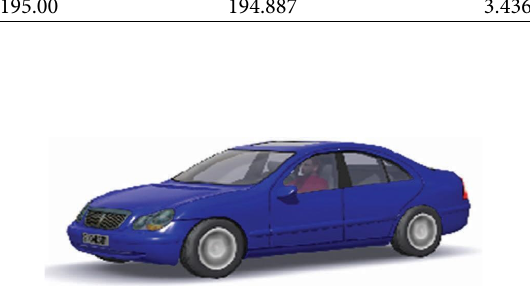
Figure 2: E-class sedan.